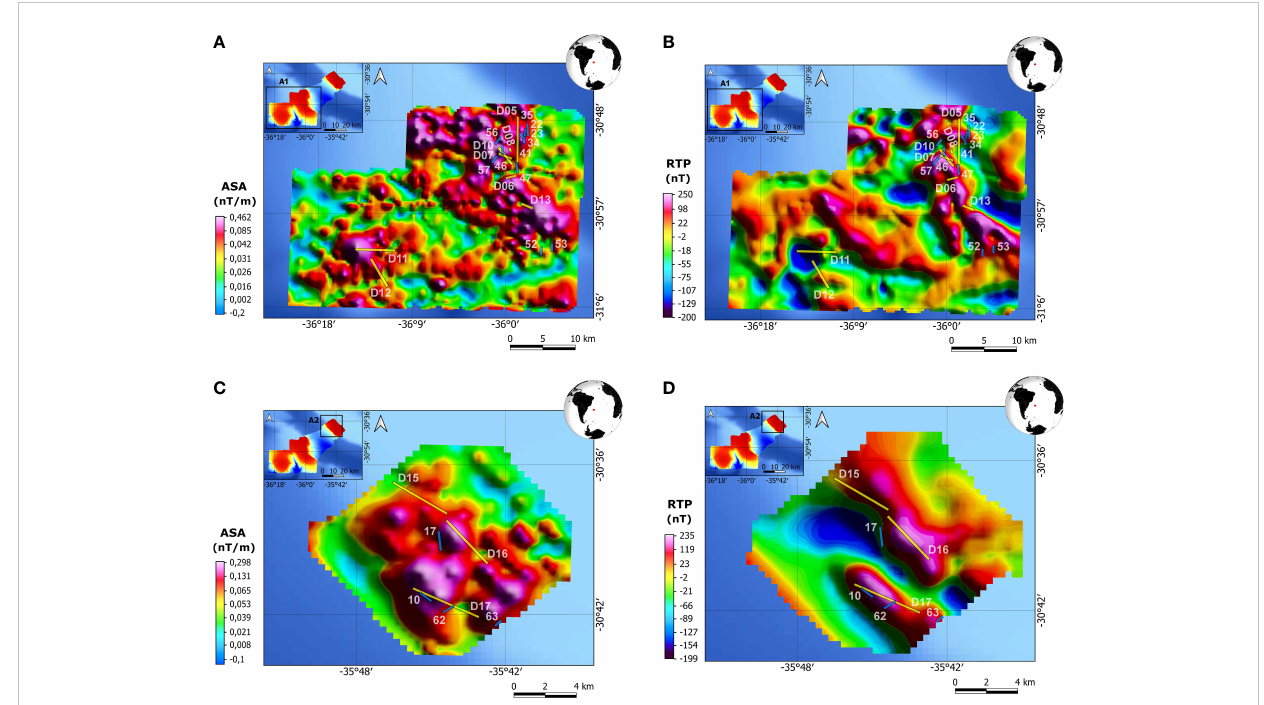
FIGURE 9 Result magnetic maps with the dredge tracks during RGR-1 (in yellow) and DY094 (in blue) cruises in areas A1 and A2. (A) 3D Analytical Signal (AS3D) map, and (B) Reduction to Pole (RTP) map from area A1 containing dredges D05, D06, D07, D08, D10, D11, D12, and D13 in yellow and 22, 23, 34, 35, 41, 46, 47, 52, 53, 56 and 57 in blue. (C) 3D Analytical Signal (AS3D) map, and (D) Reduction to Pole (RTP) map from area A2 containing dredges D15, D16 and D17 in yellow and 10, 17, 62 and 63 in blue. All maps have a grid cell size of 450